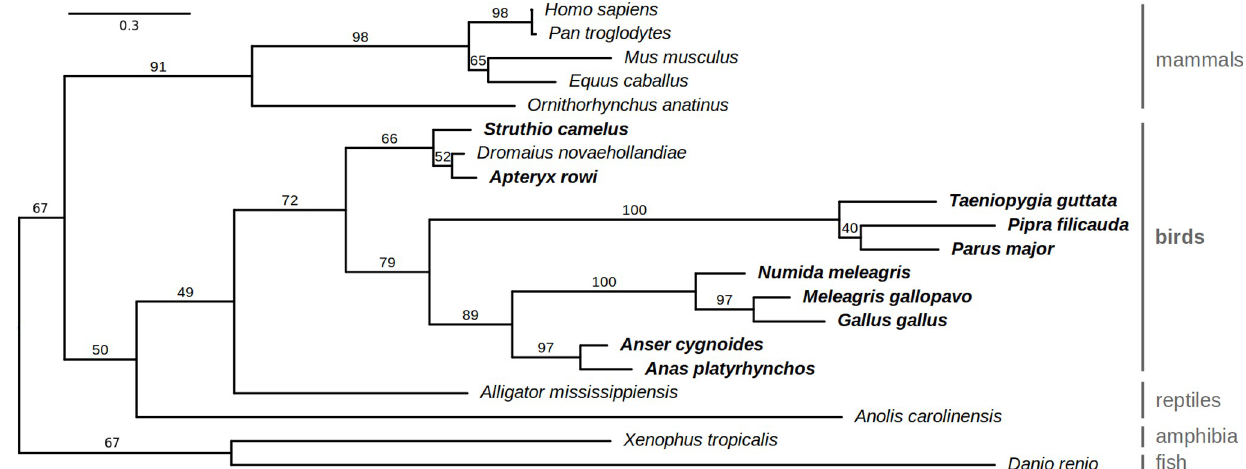
Fig 1. Phylogenetic relationship of LAT genes from birds and other vertebrates. The maximum likelihood tree was constructed from the newly identified avian LAT sequences together with selected orthologues from other vertebrates. Bootstrap support values (percent of 500 replicates) are shown above the branches. Species with newly identified LAT sequence are in bold. The scale bar above indicates the number of substitutions per site.